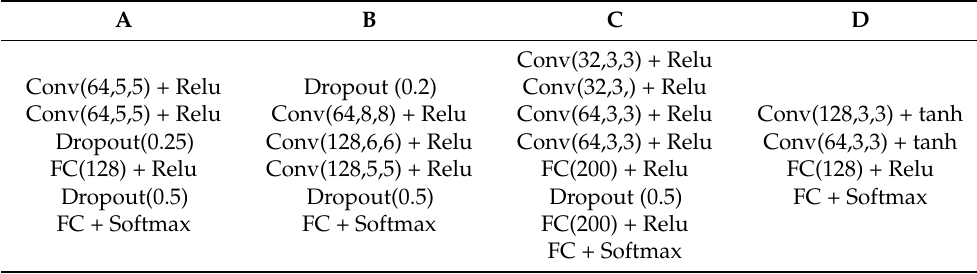
Table 1. MNIST classification